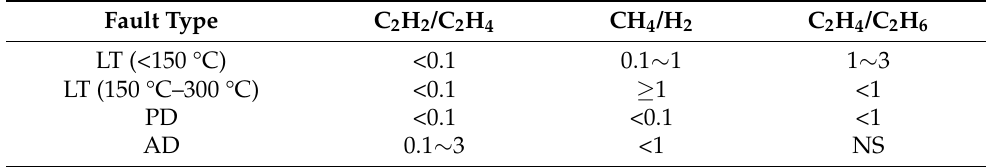
Table 1. Fault diagnosis based on IEC three-ratio